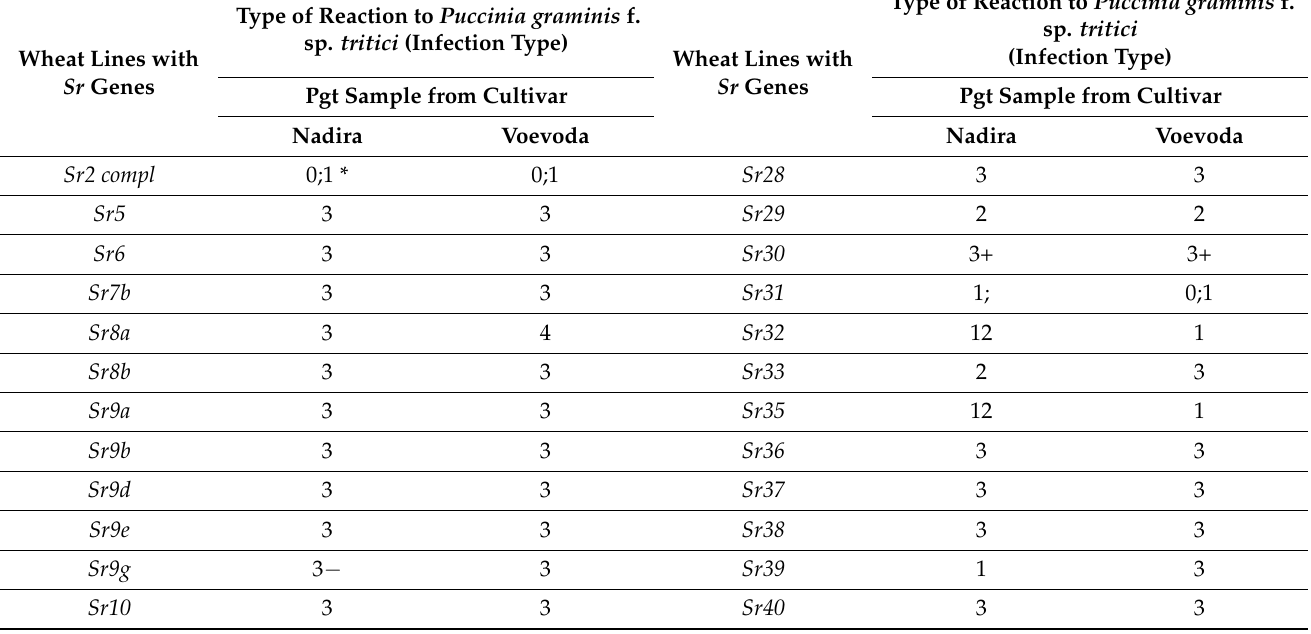
Table 1. Resistance of Sr wheat lines to population samples of P. graminis f. sp. tritici 2022. Type of Reaction to Puccinia graminis Wheat Lines with Sr Genes